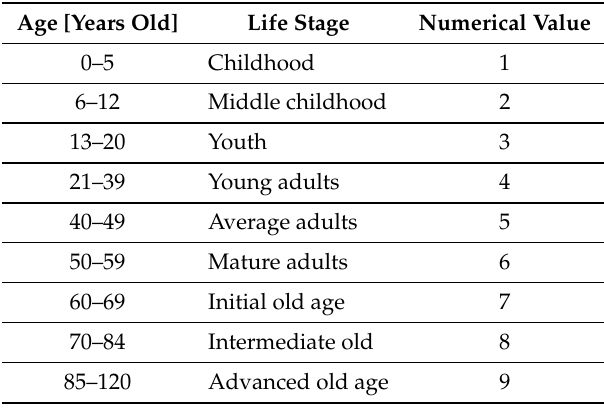
Table 3. Pre-processing of age factor.